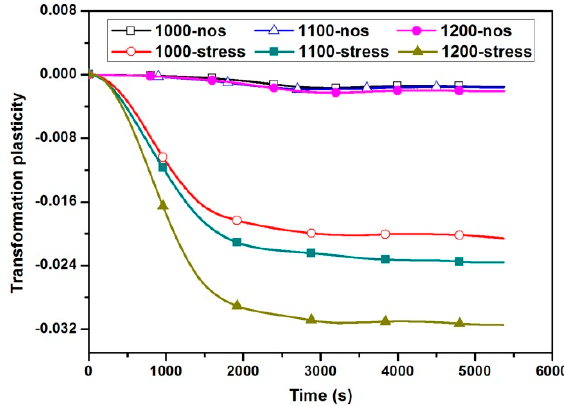
Figure 7. Transformation plasticity (TP) strain of different specimens during the bainitic transformation at 330 °C.